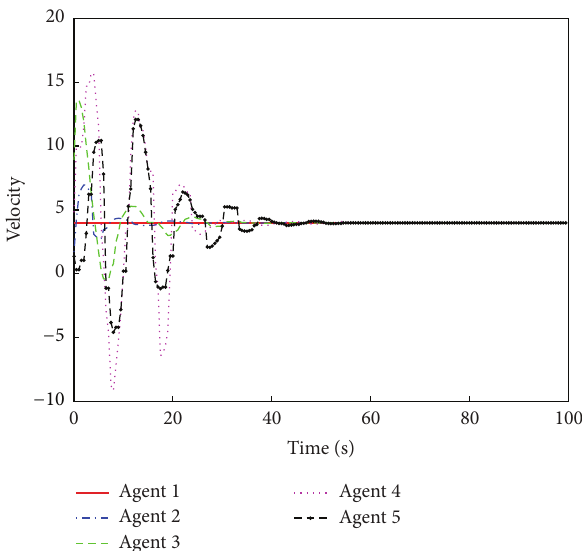
Figure 7: Consensus of velocity for high-order